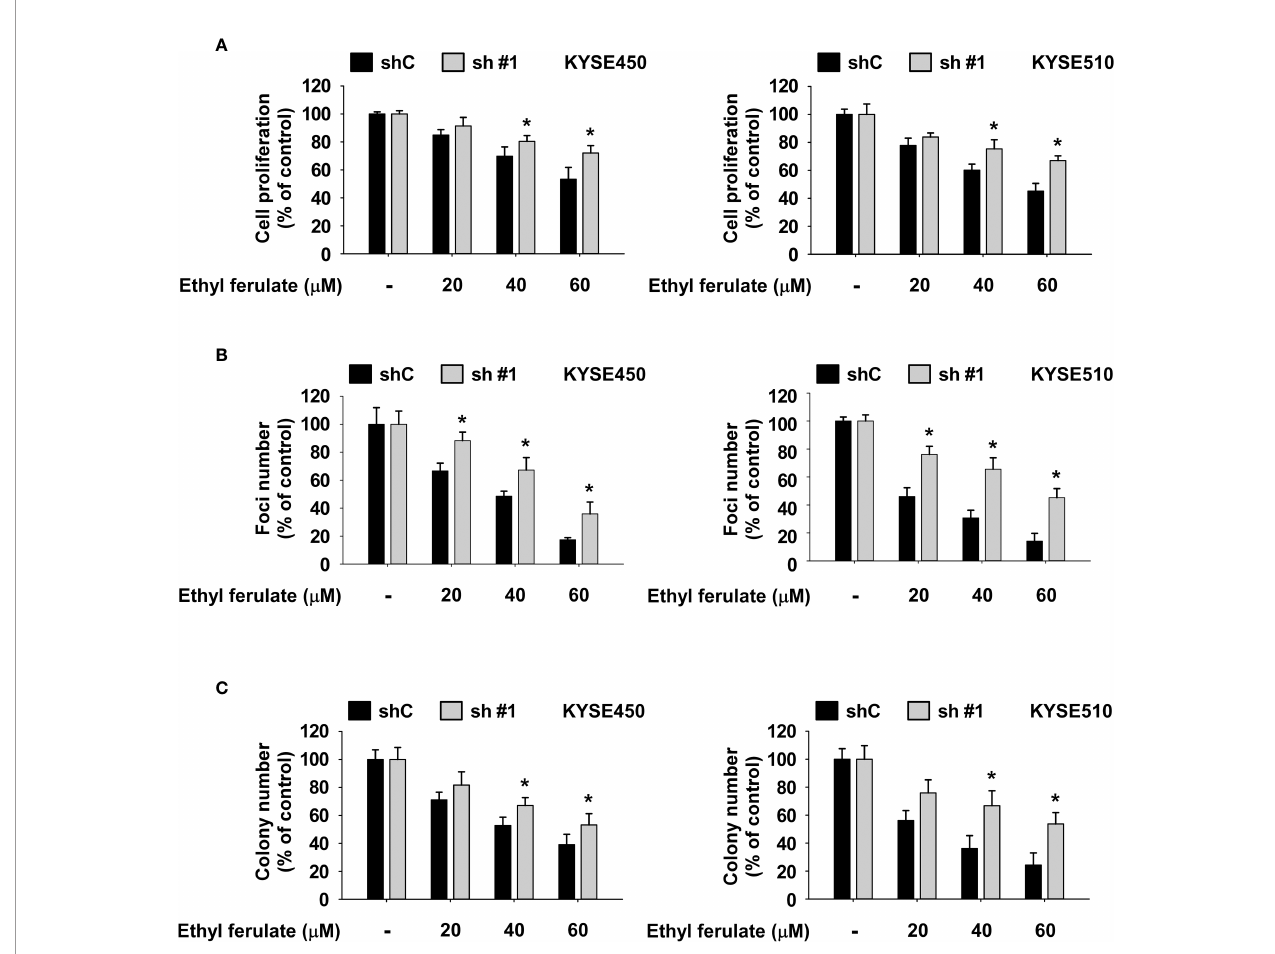
FIGURE 5 | The inhibition of esophageal squamous cell carcinoma (ESCC) cell growth by ethyl ferulate is dependent on the expression of mammalian target of rapamycin (mTOR). (A, B) The effect of ethyl ferulate on ESCC cancer cell growth and focus formation ability was assessed in cells stably expressing shmTOR or cells stably expressing shControl. Cells were treated with or without ethyl ferulate for 72 h or 10 days, respectively. Cell growth was analyzed by MTT and focus formation assays. (C) The effect of ethyl ferulate on anchorage-independent ESCC cell growth was assessed in cells stably expressing shmTOR or cells stably expressing shControl. Cells were treated with or without ethyl ferulate for 2 weeks, and then colonies were counted using a microscope and the Image-Pro PLUS (v.6) computer software program. All data are shown as means ± SD of values from 3 independent experiments. The asterisk (*) indicates a signi fi cant effect ( P < 0.05) of ethyl ferulate treatment between mTOR knockdown cells and shControl cells. The Student ’ s t test with one-way ANOVA was used to compare signi fi cant